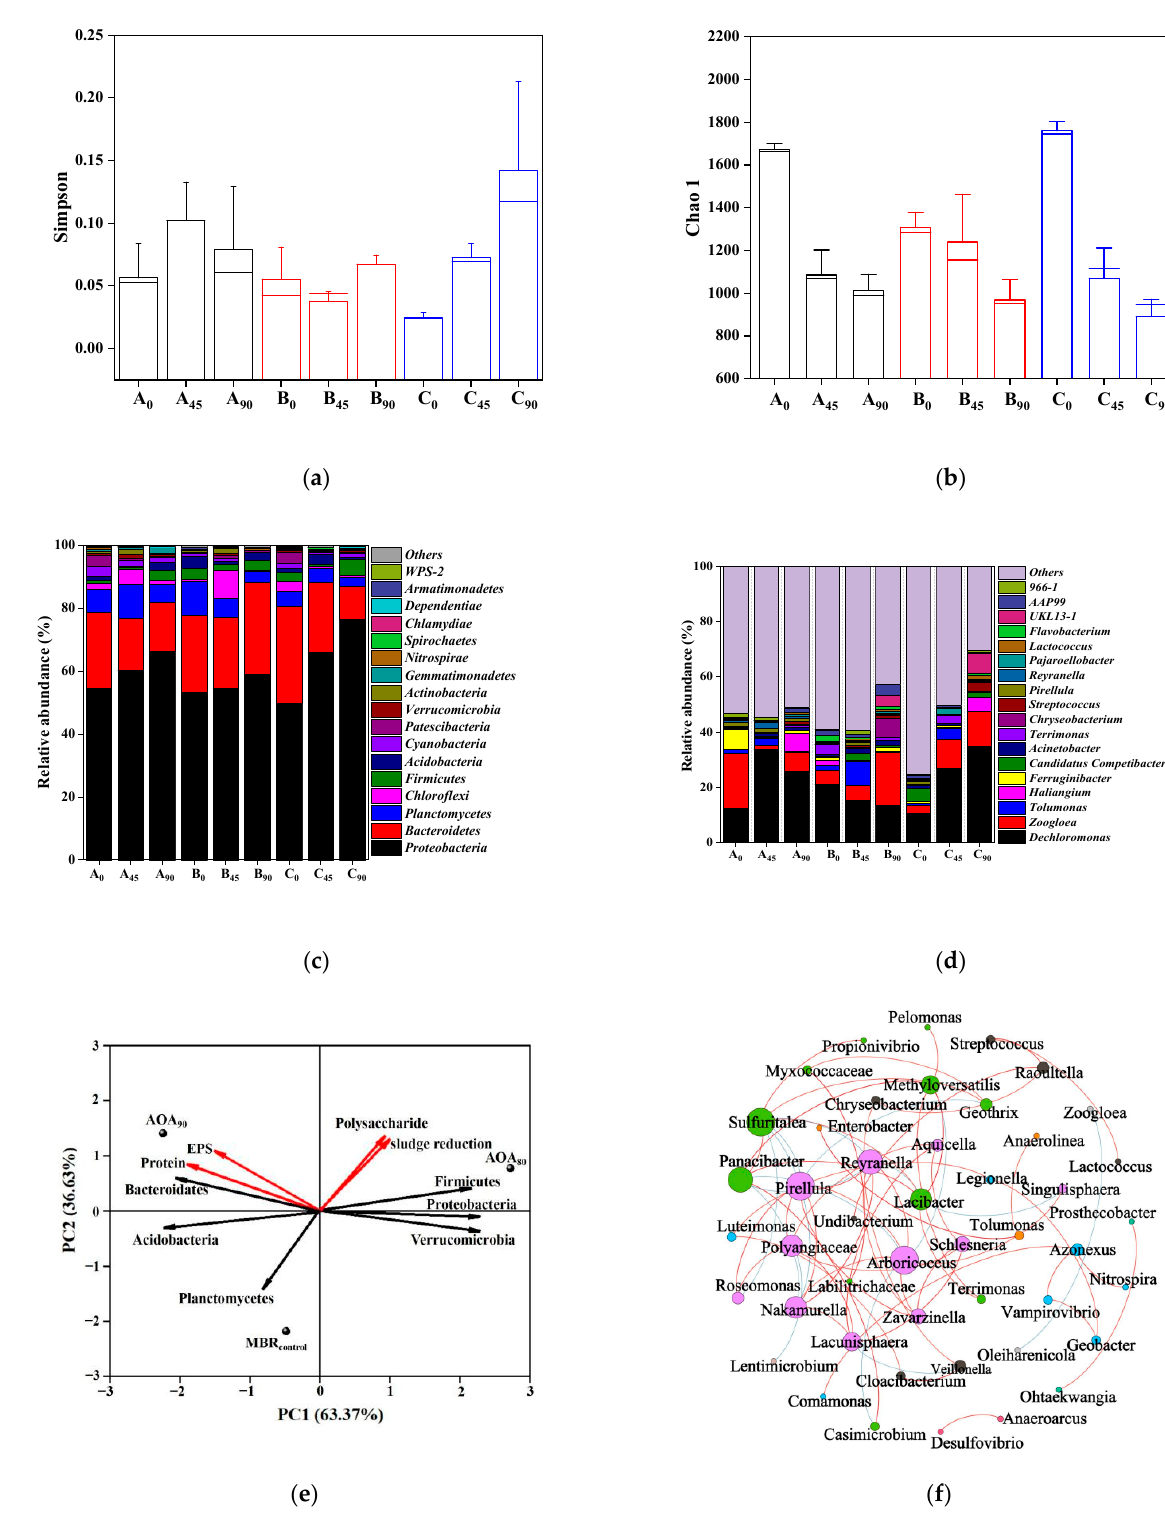
Figure 5. The Simpson index ( a ), Chao 1 index ( b ), relative abundance of dominant species at the phylum level ( c ) and genus level ( d ), PCA between bacteria community at the phylum level and sludge reduction ( e ) and co-occurrence network ( f ). (A, B, and C represent MBR control , AOA 90 and AOA 80 , respectively, and the subscript of A, B, and C means the sampling time). Further analysis of microbial community at the genus level was also conducted (Figure 5d). Dechloromonas and Zoogloea were the dominant genera of three bioreactors. Dechloromonas, the slow-growing bacteria with the function of denitrification [46], was the most abundant genus in AOA 80 (34.76% at the 90th day of operation). Zoogloea was known as the denitrifying bacteria [23] and could facilitate the removal of organic compounds [51]. The relative abundance of Zoogloea in AOA 90 was the highest among three bioreactors at the 90th day of operation. Chryseobacterium with the highest richness in AOA 90 would also induce EPS degradation due to its good proteolytic ability [52]; therefore, resulting in the cell lysis in AOA 90 . These findings confirmed that the slow-growing and hydrolytic microorganisms played a critical role on the biomass reduction in AOA 90 and AOA 80 [53,54]. The correlation of the dominant phyla of microorganisms, sludge reduction, polysaccharide, protein and EPS was conducted via PCA analysis, as shown in Figure 5e. The respective contributions of the first and second axes to the total variance accounted for 63.37% and 36.63%, respectively. Obviously, the bacteria communities of MBR control , AOA 90 , and AOA 80 bioreactors were clustered separately, which indicated that the different sludge recirculation rates induced the evolution of the microbial communities. The positive correlation between sludge reduction and Proteobacteria , Firmicutes as well as Verrucomicrobia could be clearly identified, especially in AOA 80 , while Planctomycetes had a totally negative correlation with sludge reduction in MBR control . Meanwhile, Firmicutes and B acteroidetes , phylum with the capability of organic degradation [48,50], were closely positive with polysaccharide removal in AOA 90 and protein removal in AOA 80 , respectively. The network analysis was conducted by Gephi (v 0.9.2) [55] to uncover the possible correlation (Pearson’s correlation coefficient ρ > 0.6 and significance p < 0.01) between different genera in the bioreactors (Figure 5f). Different modules were distinguished by node colors, while node size was determined by the number of node connections. The orange and blue edges that connected two nodes were used to illustrate the positive and negative correlations [56]. Close positive relationships were found among dominant genera compared to negative interactions. The slow-growing bacteria Sulfuritalea , Zavarinella and Azonexus [26,54] exhibited a positive correlation with many other genera. Sulfuritalea was positively correlated with Lacibacter , Pirellula and Reyranella, which were